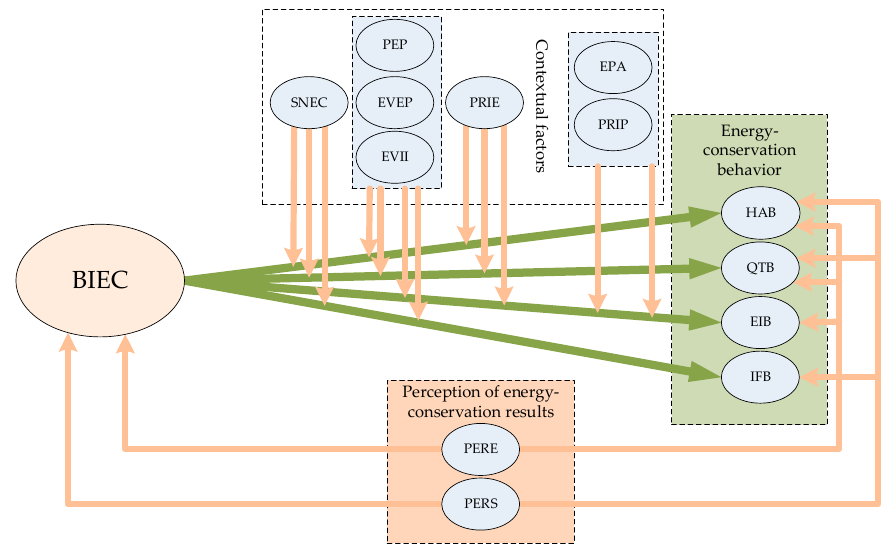
Figure 2. The modified conceptual framework of ECB.